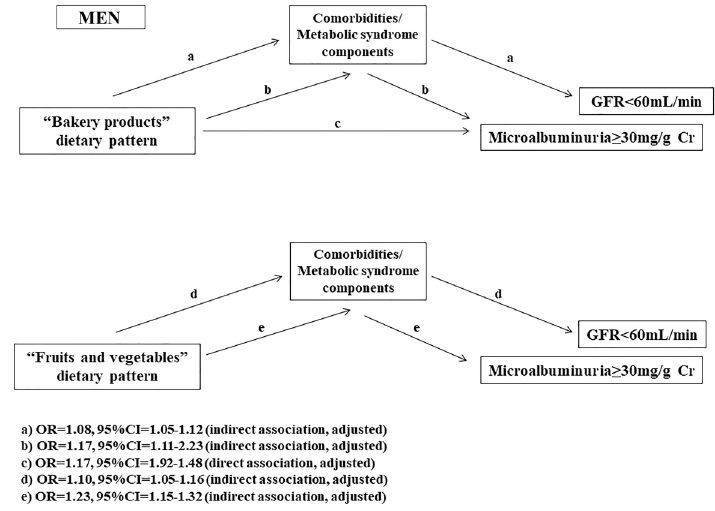
Figure 2. Results of mediation analysis. Association between dietary patterns and renal function mediated by metabolic syndrome for men (analysis adjusted for age, gender, ethnicity, and level of schooling). Comorbidities/metabolic syndrome components: elevated waist circumference, hypertension, diabetes, dyslipidemia, and